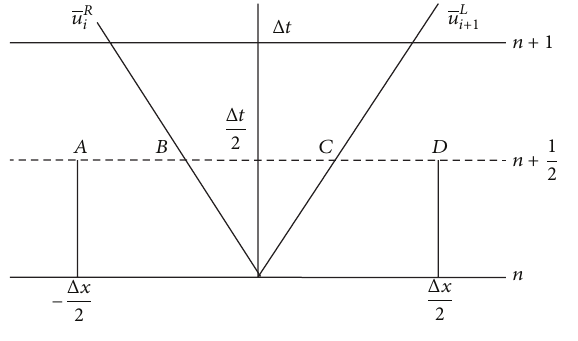
Figure 8: 𝑢 𝑅 𝑖 ≤ 𝑢 𝐿 𝑖+1 rarefaction